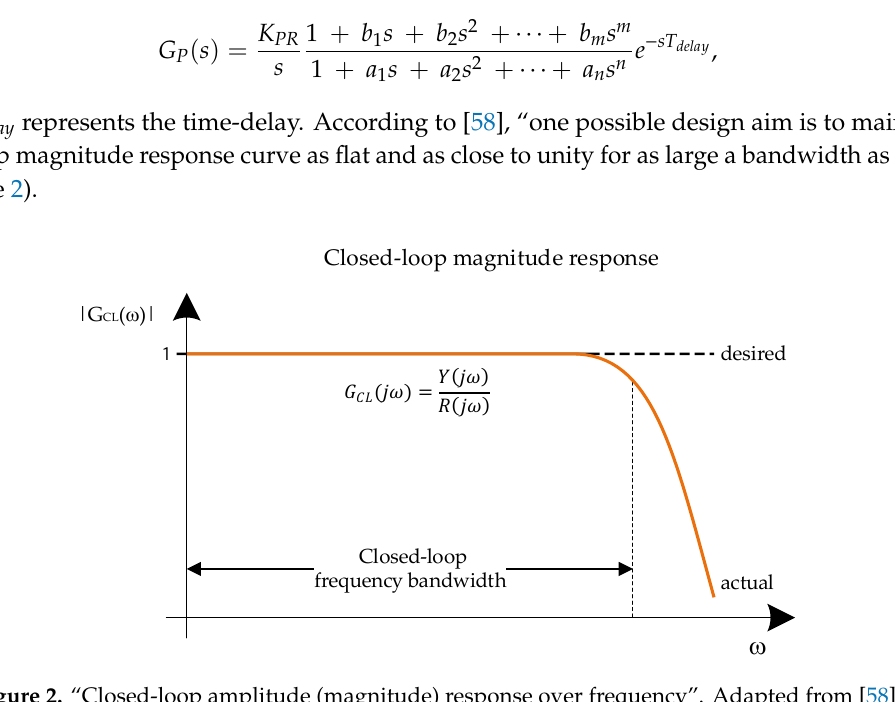
Figure 2. “Closed-loop amplitude (magnitude) response over frequency”. Adapted from [58].